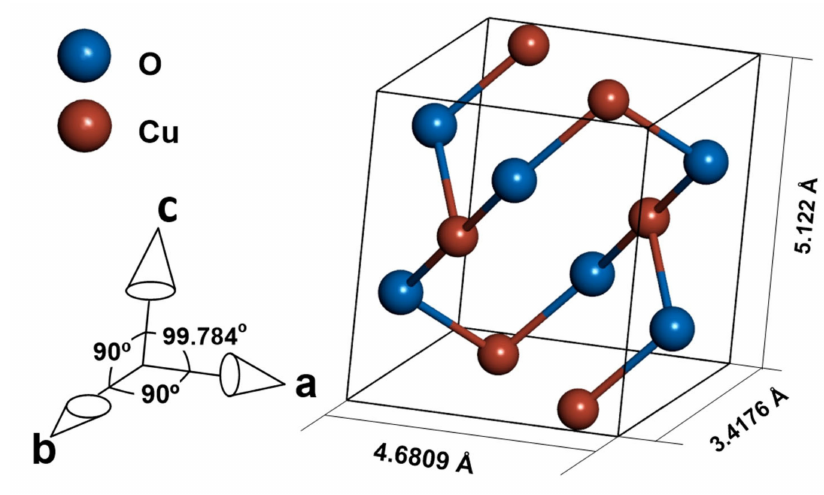
Figure 1. Crystal structure of